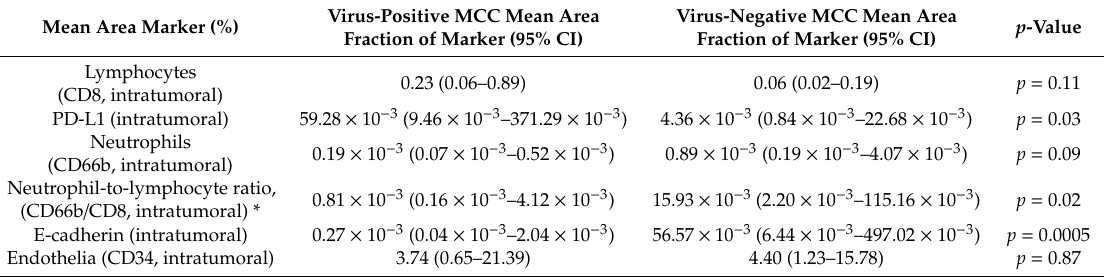
Table 1. This stain area fraction (in %) of immune cells and biomarkers in virus-positive and -negative Merkel cell carcinoma